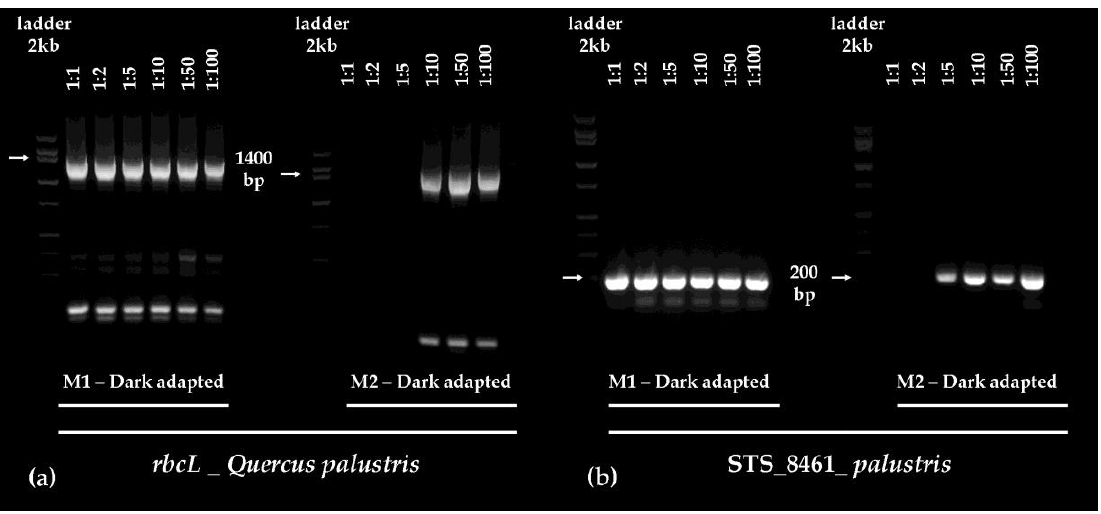
Figure 4. The impact of DNA template dilution on the amplification of the ( a ) 1300 bp rbcL and ( b ) 209 bp STS_8461_ palustris fragments from DNA template extracted from in situ dark-adapted leaves using method M1 or M2. DNA templates were diluted in sterile, nuclease free water at ratios of 1:1, 1:2, 1:5, 1:10, 1:50, and 1:100, as denoted in the upper segment of the panels. 2 kb DNA ladder was used for amplicon size determination. Arrows point to the ( a ) 1400 bp and ( b ) 200 bp fragment position marker, for reference.